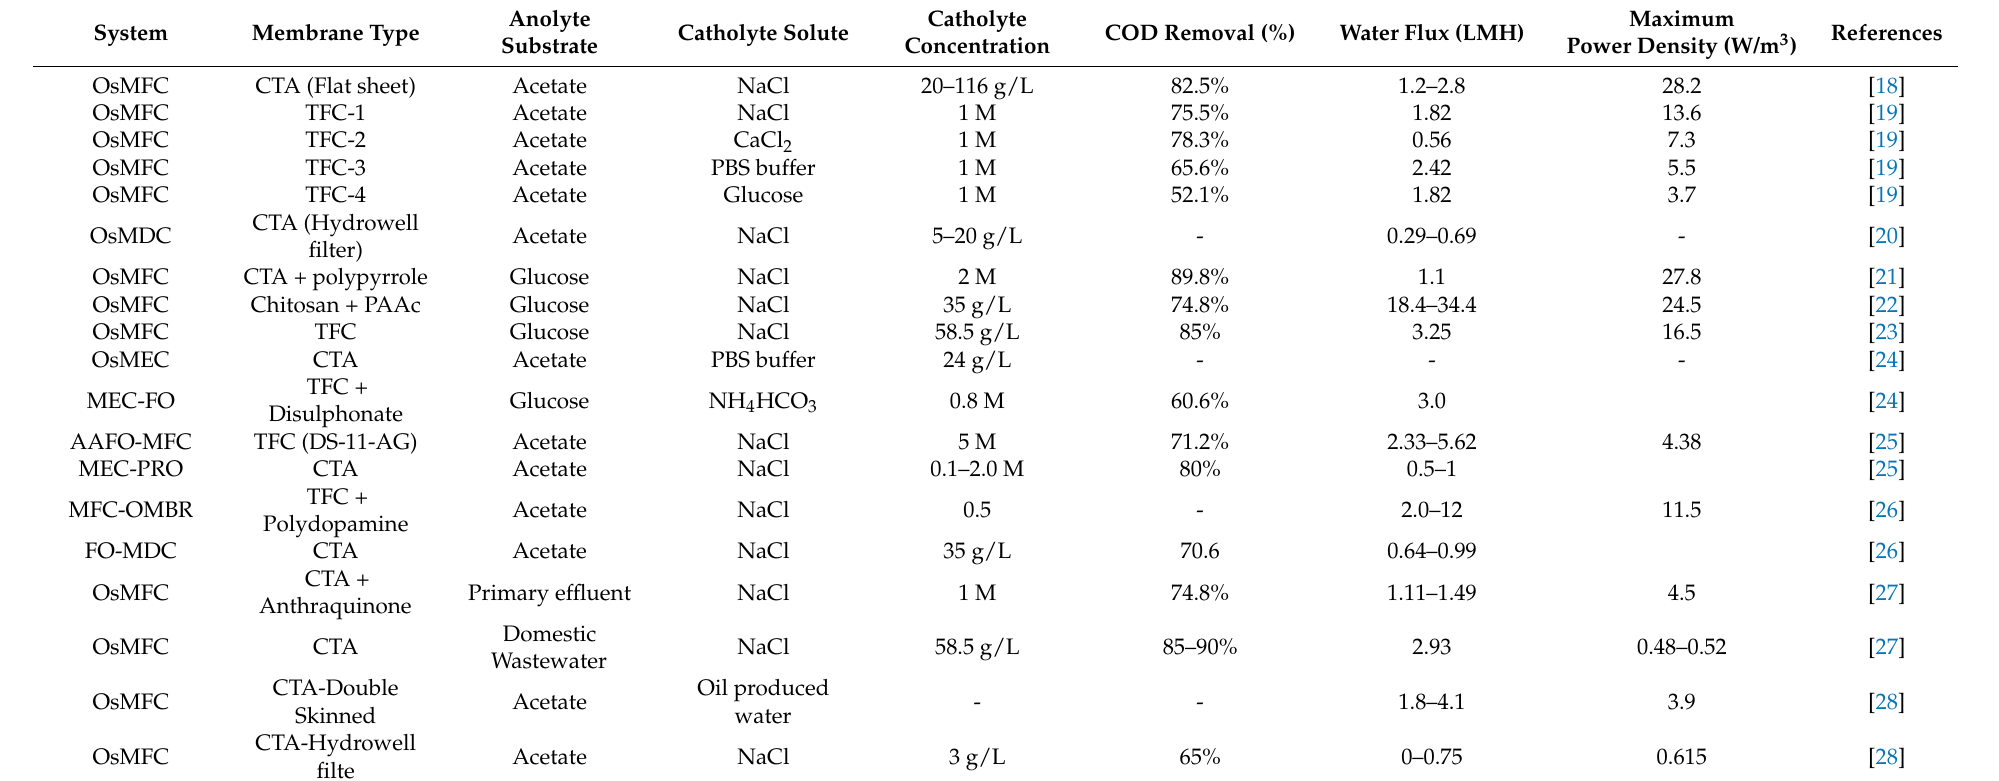
Table 1. Summary of the OsBES studies for water recovery and energy